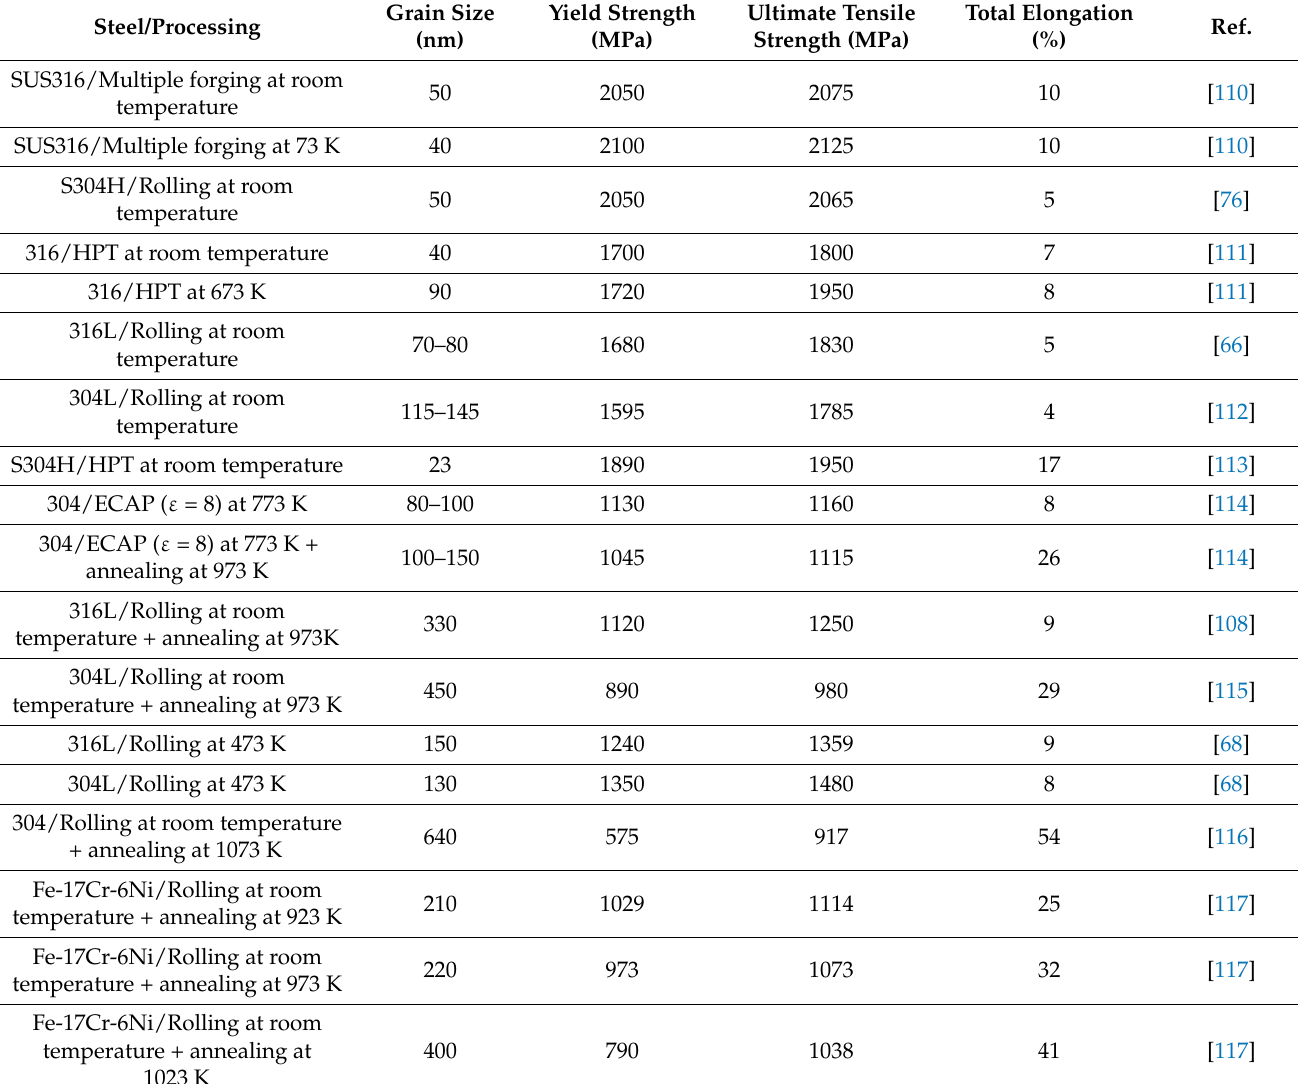
Table 1. Grain size and strength of some UFG stainless steels after